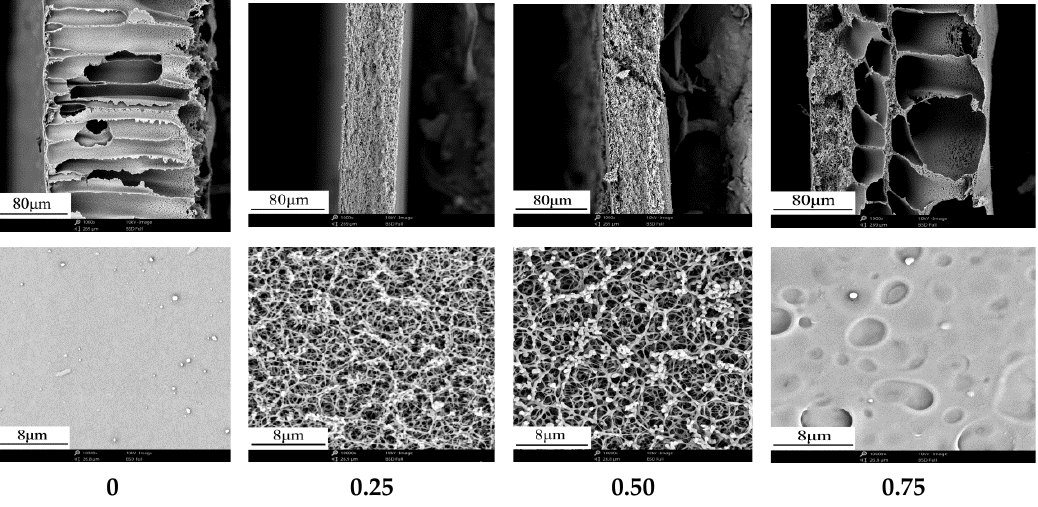
Figure 3. Effect of acetone/solvent ratio on the cross-section and surface microstructure of membranes. Table 4. The properties of membrane prepared under different acetone/solvent